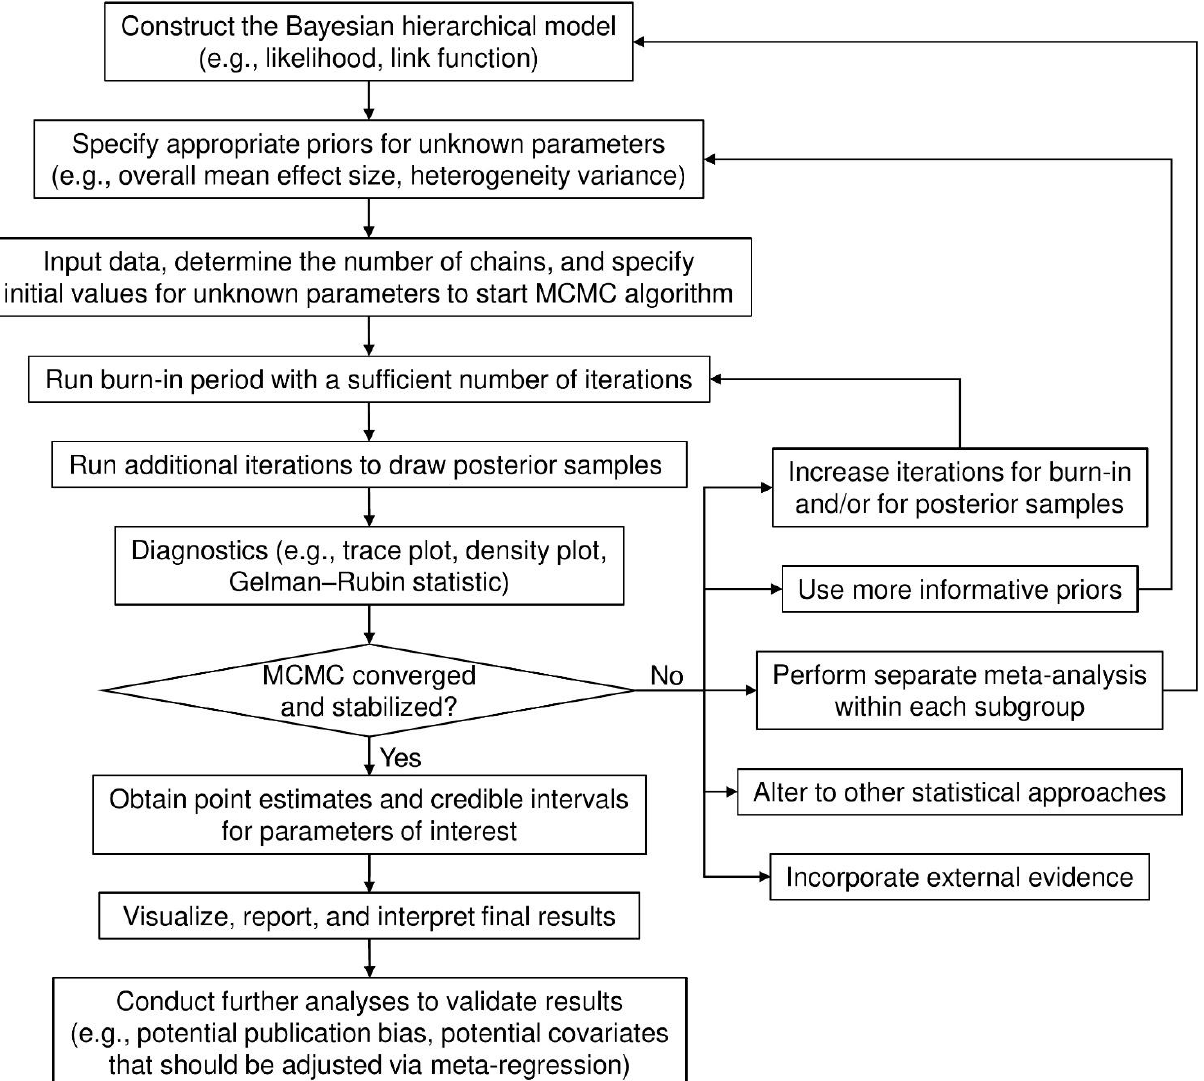
Figure 1. Flow chart for implementing a Bayesian meta-analysis.